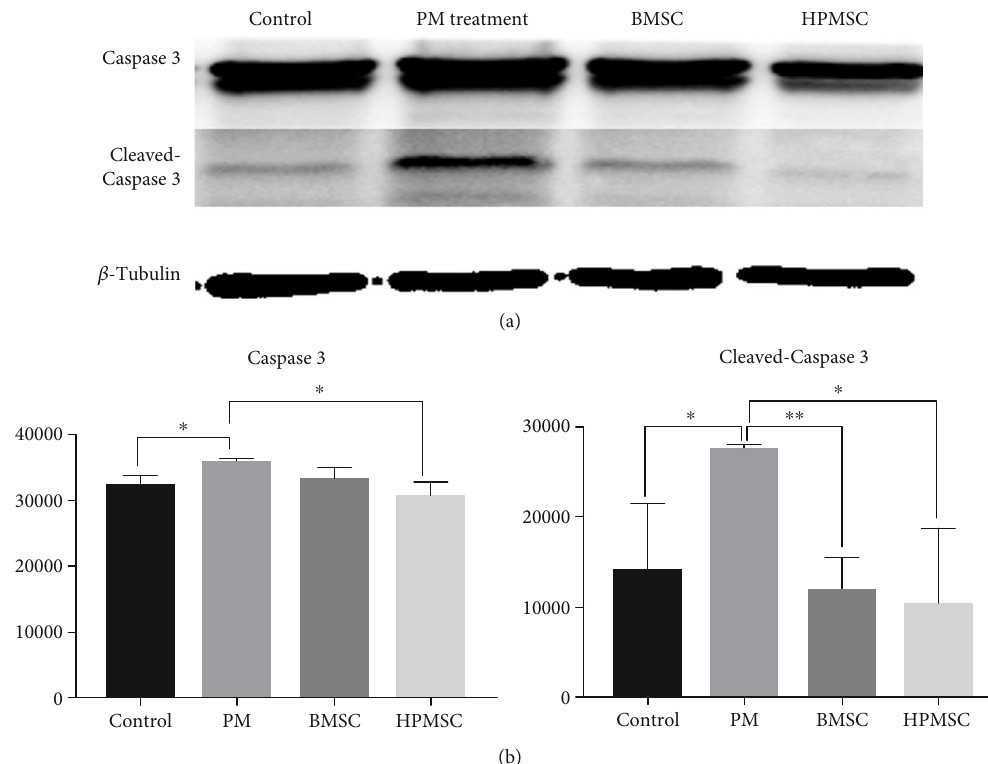
Figure 7: (a) Detection of di ff erences in the protein expression of apoptosis-associated Caspase 3 zymogen and cleaved-Caspase 3 in 4 groups of cells by Western blot. (b) Analysis of di ff erence in gray values. The di ff erences were statistically signi fi cant. ∗ P < 0 : 05 ; ∗∗ P < 0 : 01